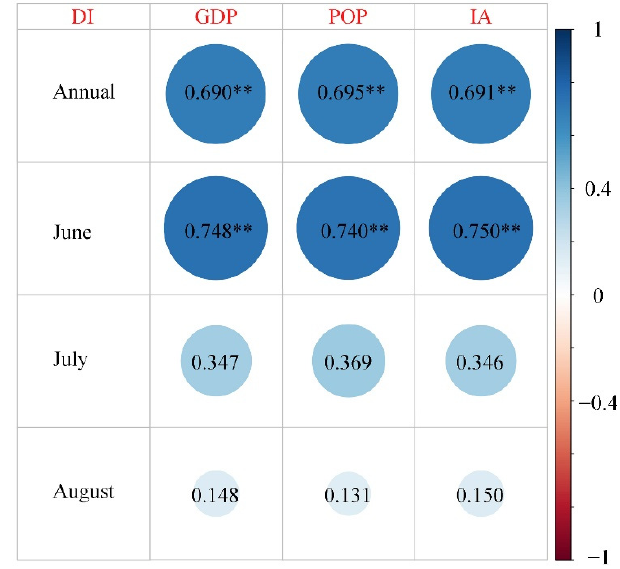
Figure 8. Correlations between human activity factors and DI (*: p < 0.05 **: p < 0.01).